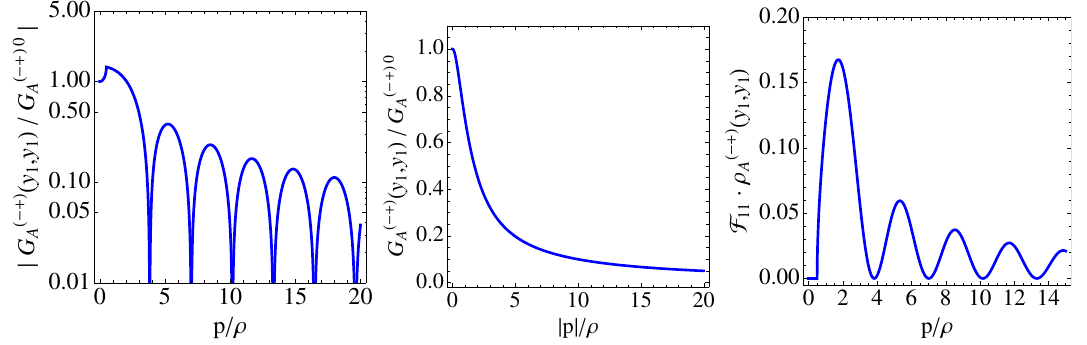
( y 1 , y 1 ; p ) /G ( − +)0 | for p 2 > 0 (left A A